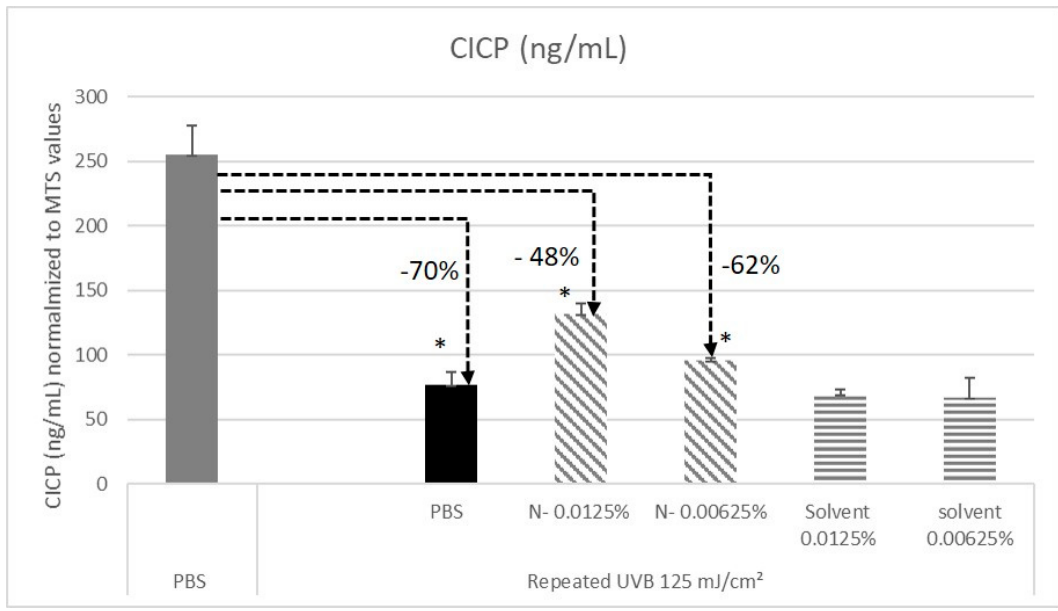
Figure 6. Quantification of Procollagen Type I C Propeptide (CICP) secreted in the supernatant of normal human fibroblasts dermal fibroblasts NHDFs under various conditions. Elisa assay. The study was done in triplicate (* p < 0.05, student t test).